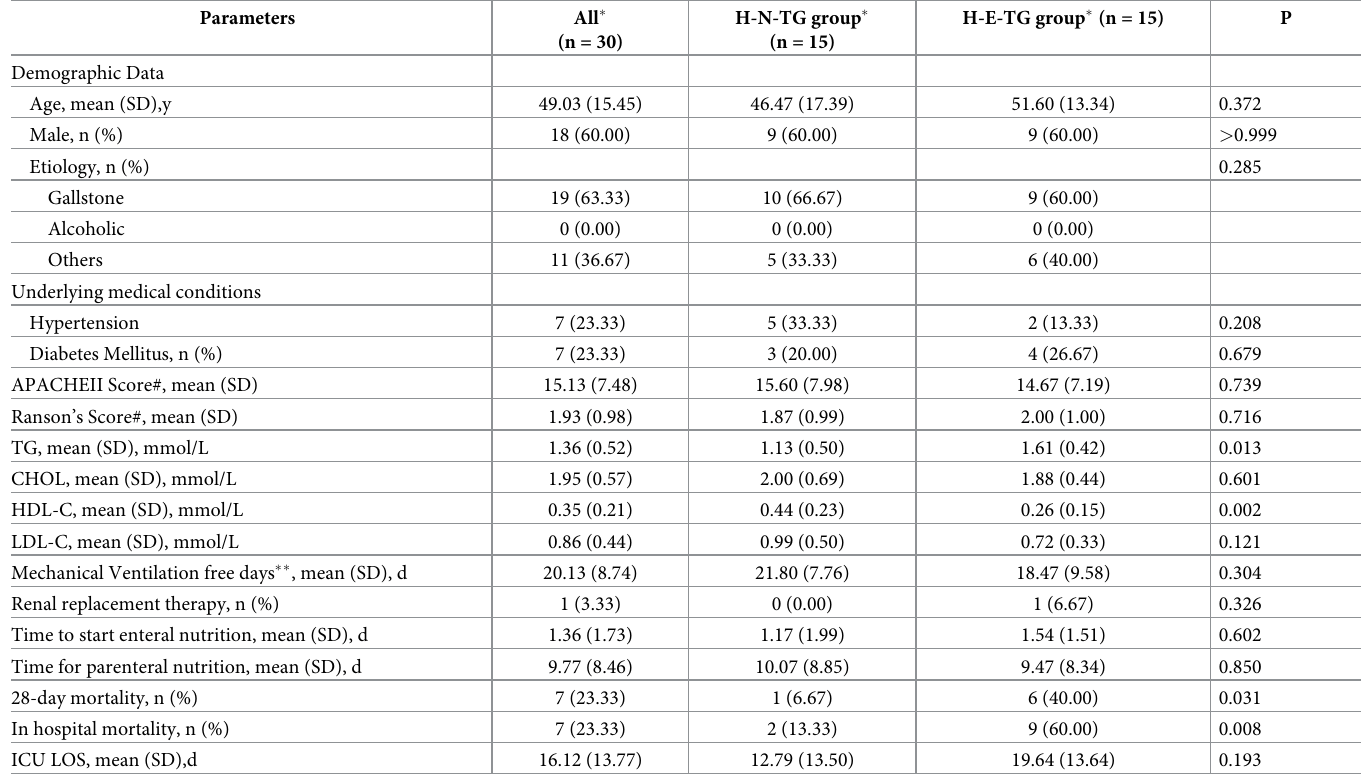
Table 3. Propensity score matching analysis of N-TG SAP patient cohort.